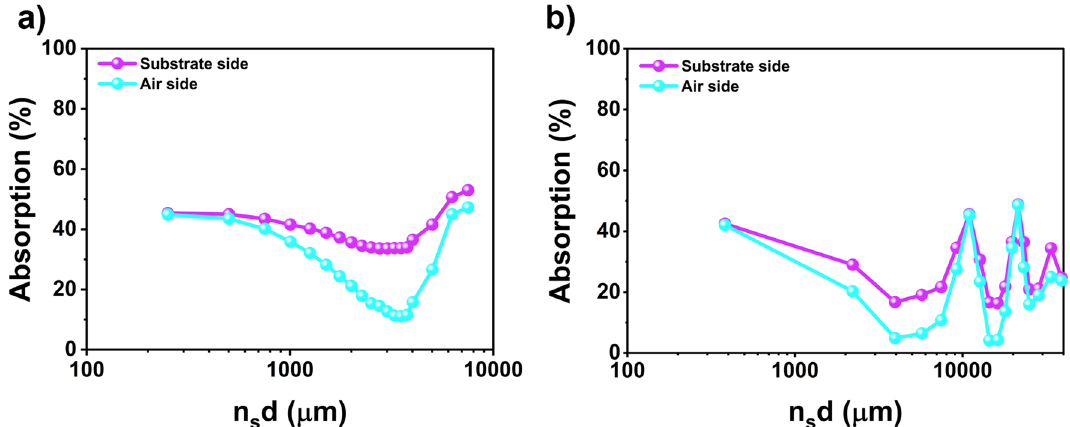
Figure 4. Absorption amplitude of 6.5 nm gold film on against effective thickness n s d of the (a) glass and (b) silicon substrate. Note that the absorptions are measured from both air side and sample side incident. The extinction peak for absorption is in the limit of thick substrate which is discussed before in the main text. Absorption oscillates when the substrate thickness increase, due to the Fabry–Perot interference effects (all the axis of the substrate thickness are in the log